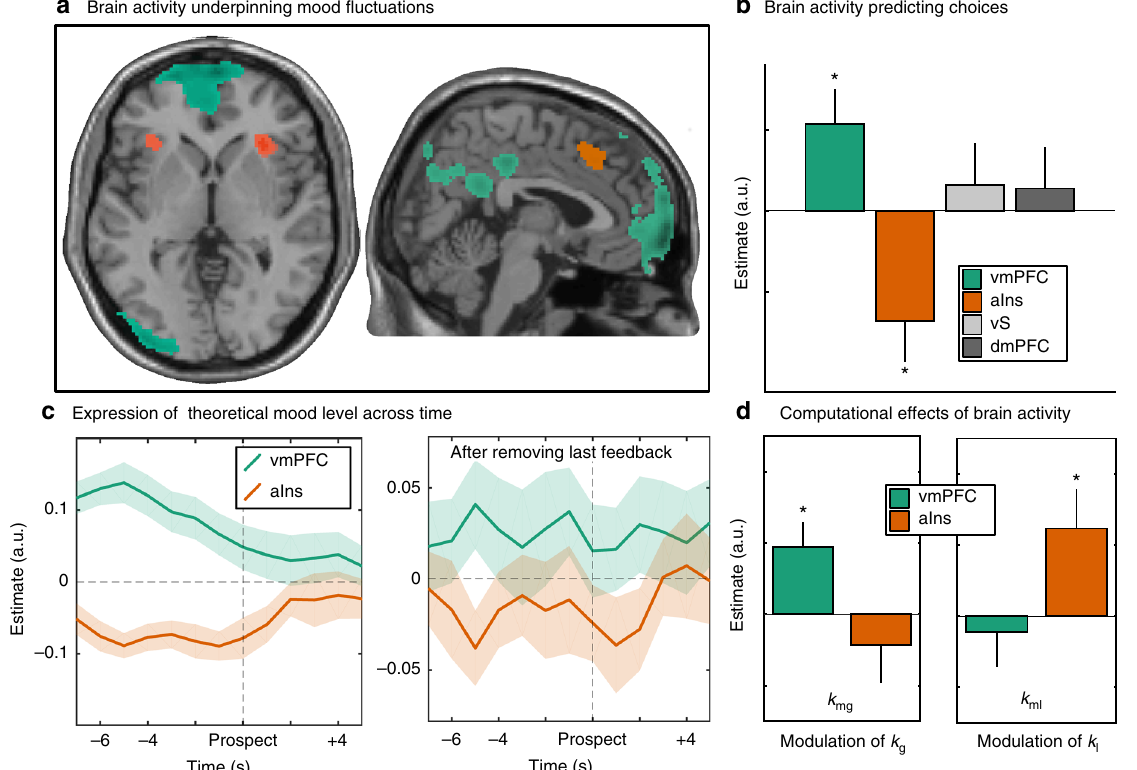
Fig. 5 Neural activity. The different panels show how baseline activity in key valuation regions re fl ects mood (top line) and affects computational parameters of the choice model (bottom line). a Statistical parametric map of regions re fl ecting TML during rest (positive correlation in green, negative correlation in red, cluster generating threshold p < 0.001, cluster size arbitrarily de fi ned for display purpose). Four ROI (vmPFC, aIns, vS, and dmPFC) were de fi ned using spheres of 8-mm diameter centered on coordinates from the literature (coordinates from ref. 42 ). b Impact of ROI activity on choice. Baseline activity was extracted for each subject and trial from our 4 a priori ROI, and orthogonalized with respect to whole-brain mean activity. The 4 trial-by-trial series were then entered in a linear regression model meant to explain the residual error of the choice model fi t. Only vmPFC and aIns were signi fi cant predictors, with opposite directions. c Contribution of vmPFC and aIns to TML. Baseline activity was extracted at each time point and entered in a linear regression model meant to predict TML. Both vmPFC and aIns were signi fi cant predictors of TML, with opposite directions, even when all variables were orthogonalized with respect to the last feedback. d Impact of ROI activity on choice model parameters. Signi fi cant modulation was only found with vmPFC for k g (weight on potential gain) and with aIns for k l (weight on potential loss). Bars represent means of parameters estimates; error bars represent